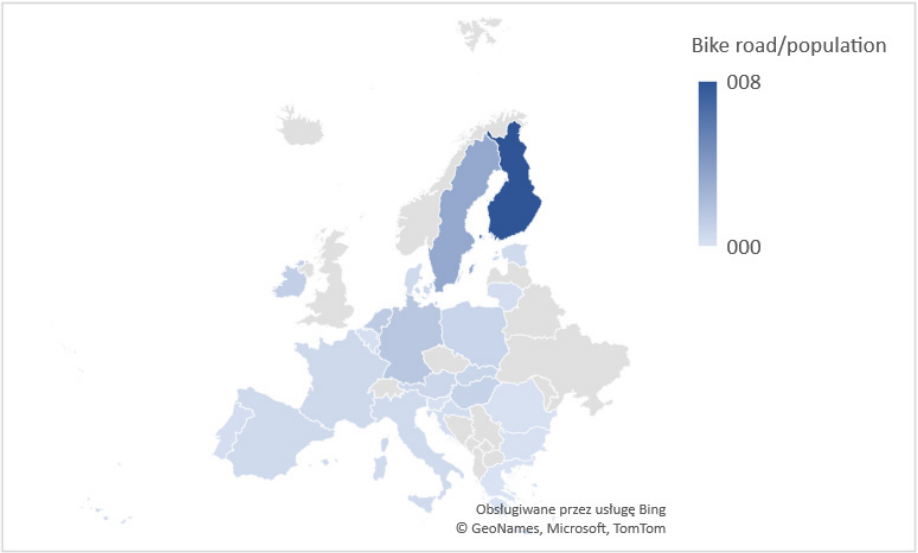
Figure 4. Bike road lengths per 1000 citizens in smart cities in European Union countries. Source: author’s analysis.